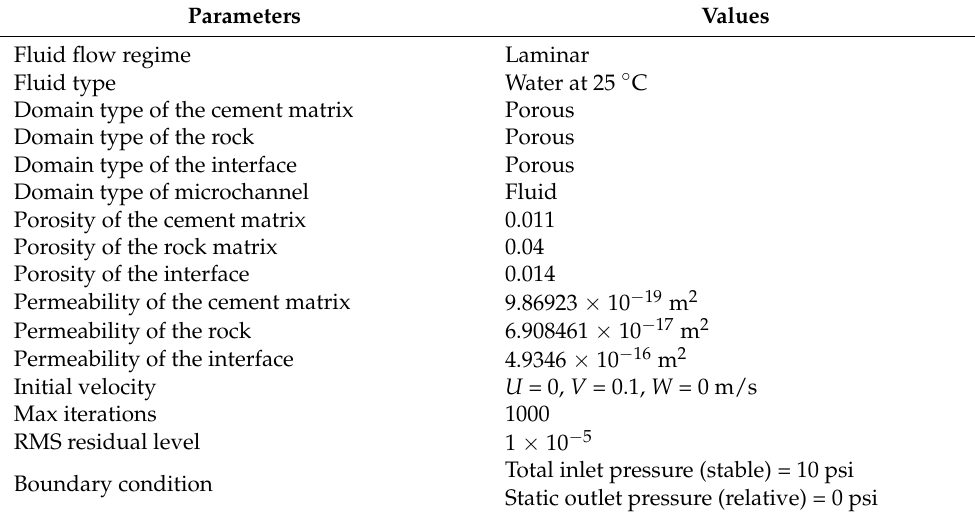
Table 2. Primary simulation parameters. Parameters Values Fluid flow